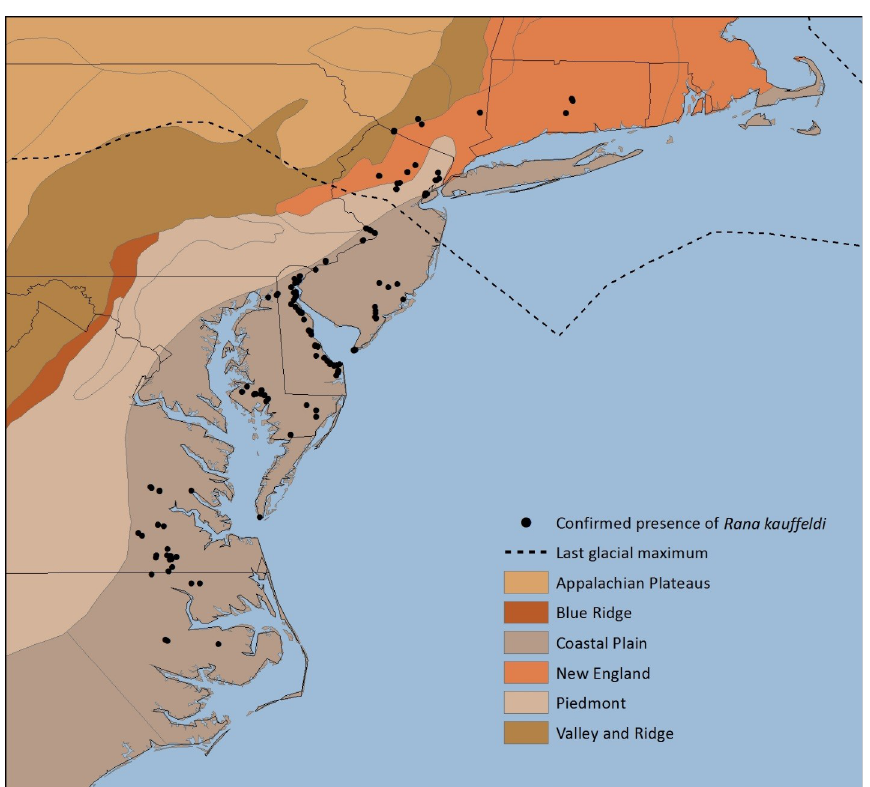
Fig 7. Physiographic regions of coastal northeastern U.S. ([58]; https://water.usgs.gov/lookup/getspatial?physio) with presence points for Rana kauffeldi confirmed by bioacoustics and/or genetics. Last glacial maximum is from Ray and Adams